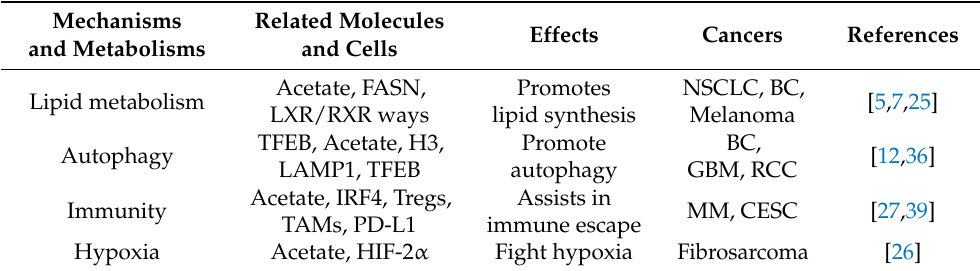
Figure 1. ACSS2 promotes lipid synthesis Nutrition stress resulted in AMPK-phosphorylation-dependent formation of ACSS2, which impacts the expression and activation of LXR/RXR to facilitate fatty acid and sterol metabolism. Moreover, ACSS2 increased the proportion of lipid synthesis derived from acetate in the cytoplasm. (Acetate and glucose line thickness indicate the proportion of participation.) α -5: importin 5. The arrows ( ↑ ) in the figures are used to highlight the increase in substance levels for easier understanding by the reader (The following figures also have the same meaning and will not be explained again). Table 2. ACSS2 interacts with intracellular molecules and cells in different tumors.